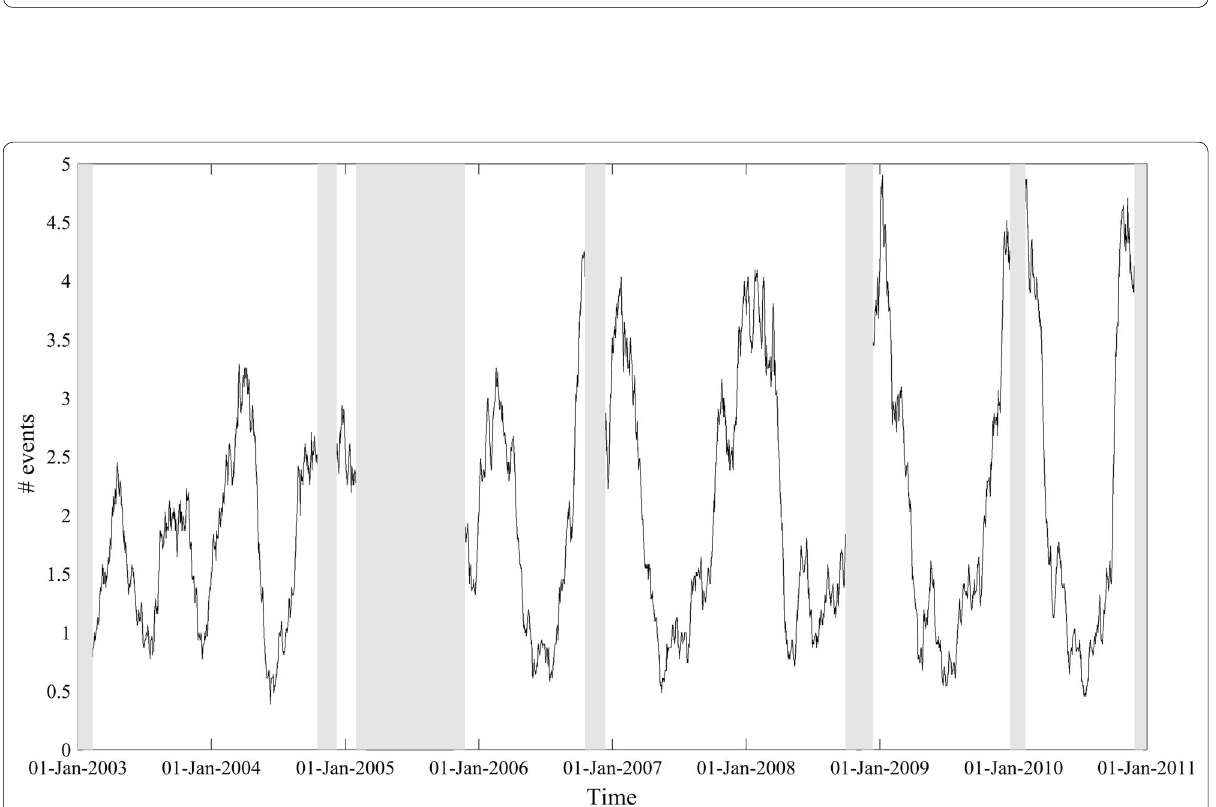
Fig. 4 Average power spectra. The average power spectra around noon (red line) and midnight (blue line), separately for summer (left panel), winter (middle panel), and equinoctial (right panel) months